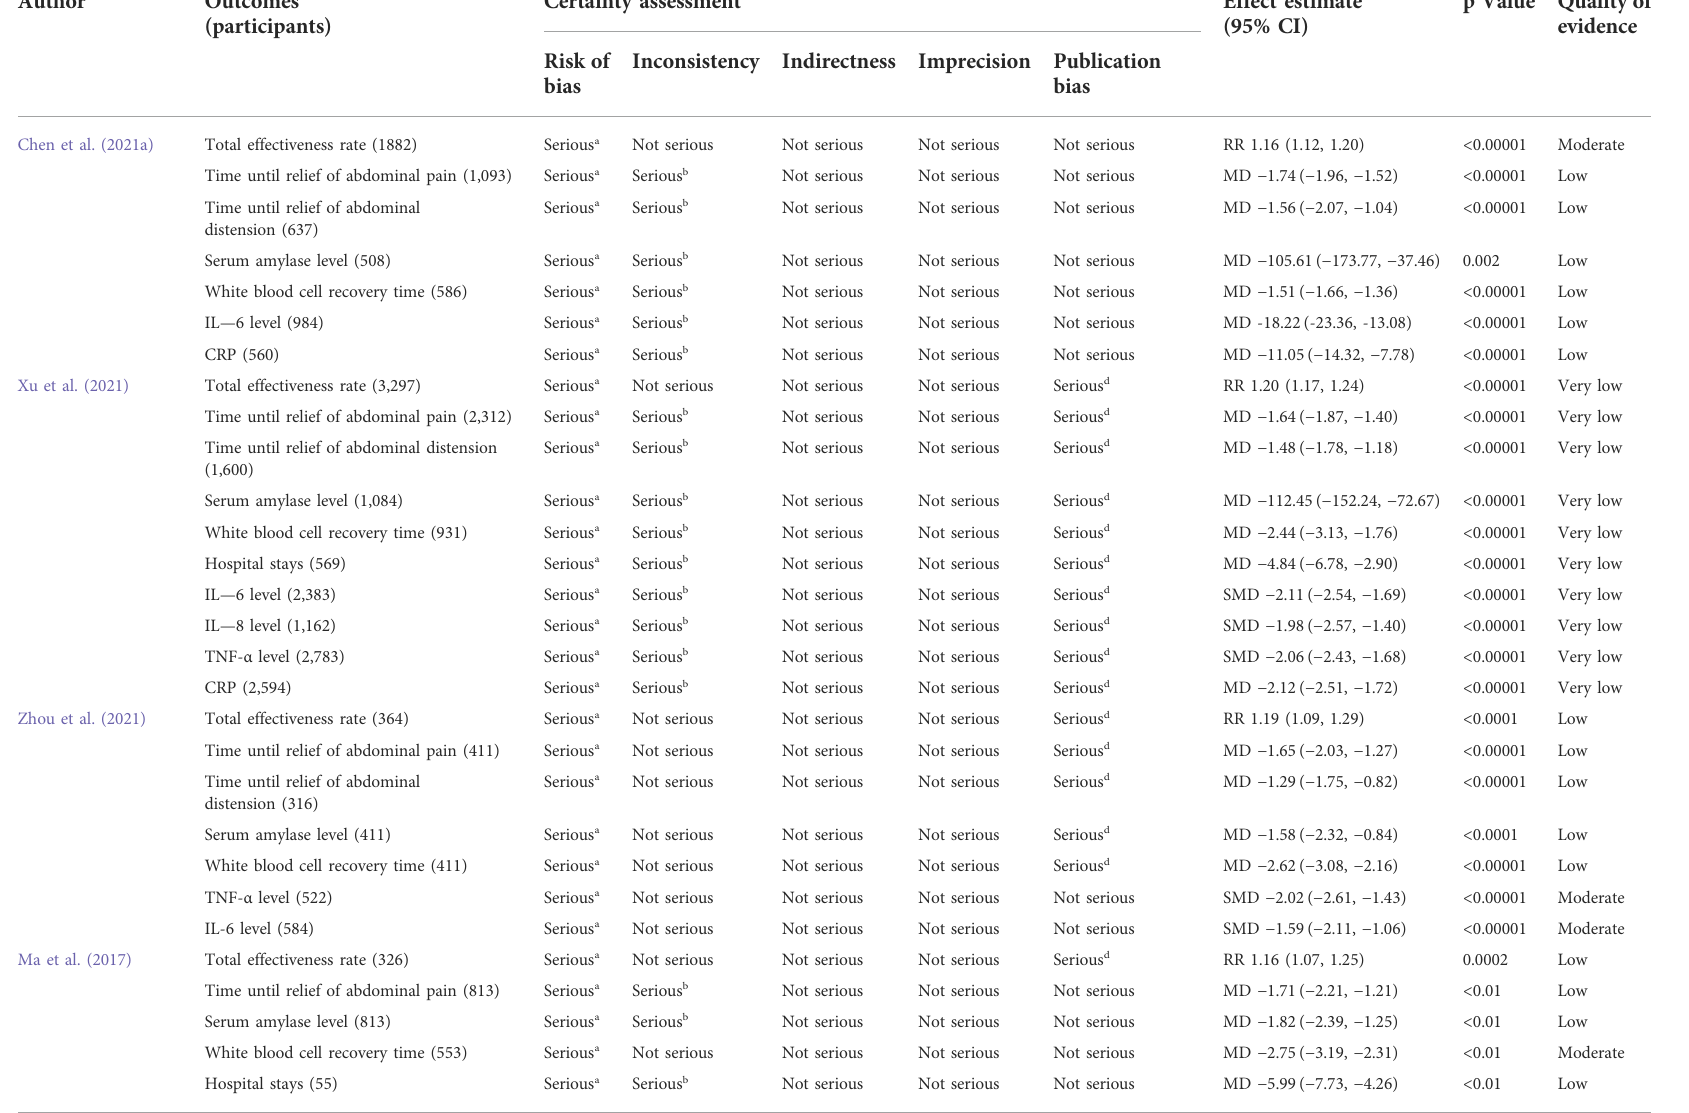
TABLE 4 Quality of evidence in the included studies assessed by